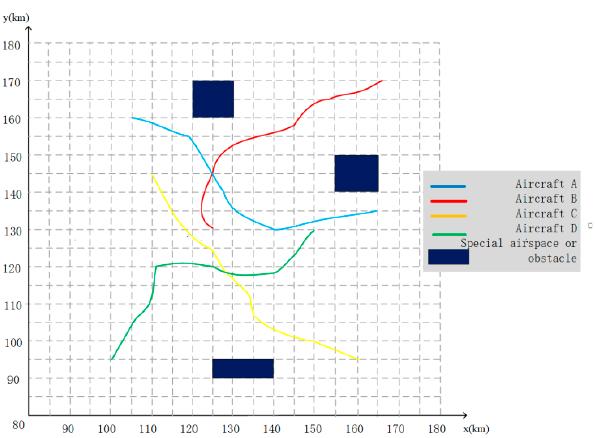
Figure 14. Schematic of 2D track planning results for four aircrafts after smoothing.